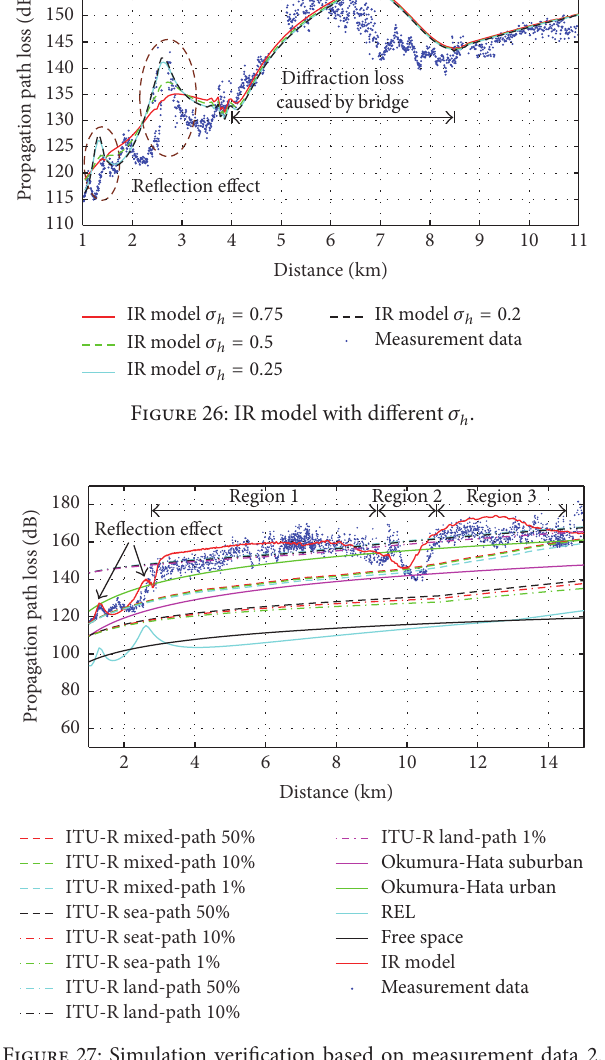
Figure 27: Simulation verification based on measurement data 2. Region 1 denotes the diffraction loss caused by obstacle 1. The dip in Region 2 is derived from space between the two buildings. Region 3 represents diffraction loss caused by obstacle 2.